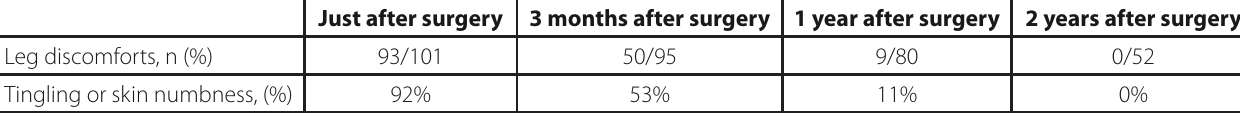
Table 4. Follow-up of leg discomforts in the harvesting site. Just after surgery 3 months after surgery 1 year after surgery 2 years after surgery Leg discomforts, n (%) 93/101 Tingling or skin numbness, (%)